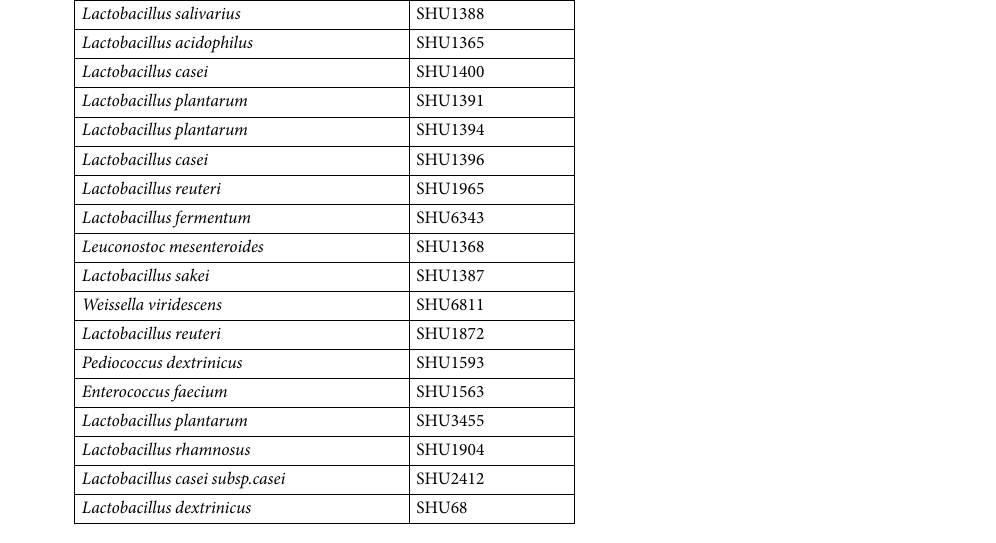
Table 1. Types of strains used in this